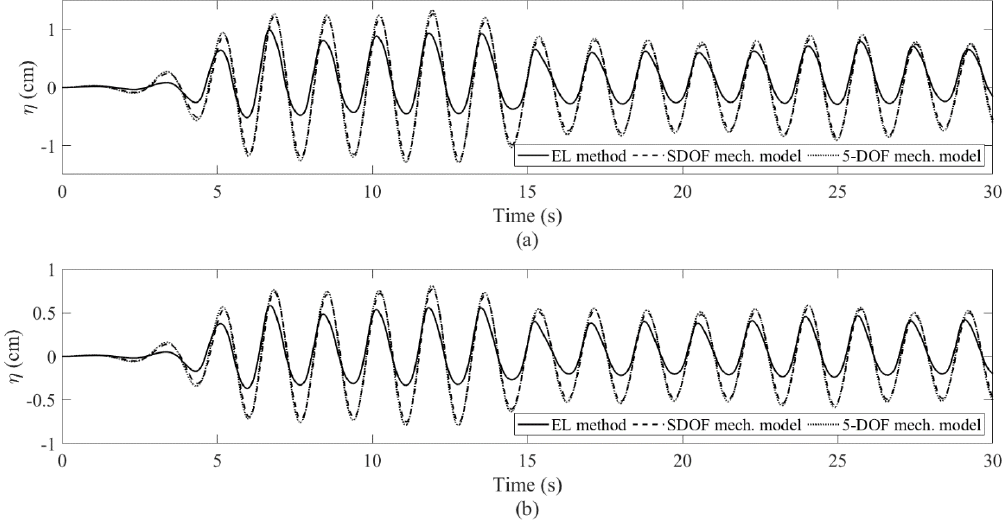
Figure 22. The free-surface elevations on the left-side wall of the tank for different wave loadings: ( a ) large wave; ( b ) small wave. ( a ) large wave; ( b ) small